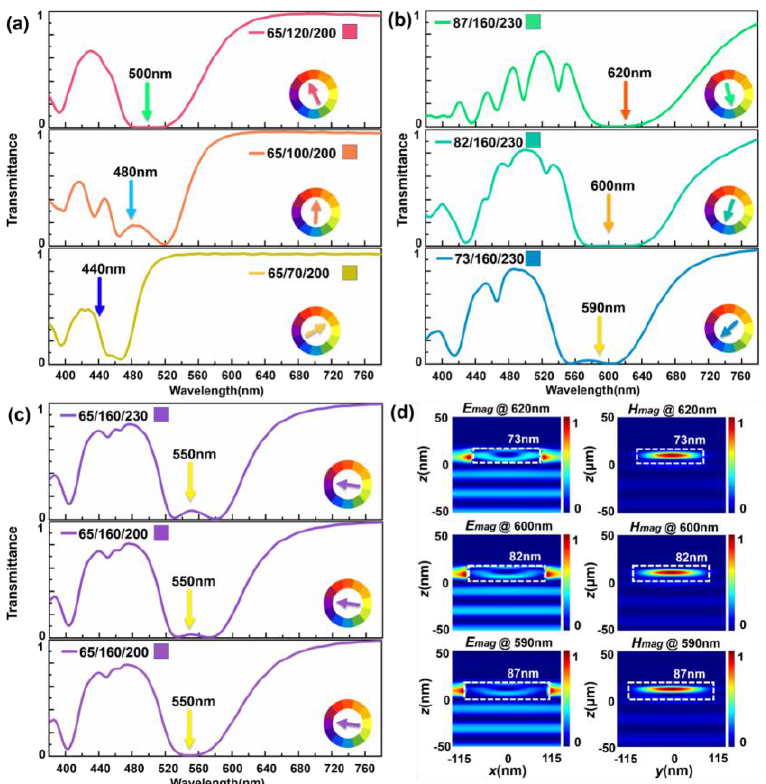
Figure 2. ( a – c ) The calculated reflection spectra of Si metasurface with different lattice sizes. ( d ) The electromagnetic field distributions of electric dipole mode and magnetic dipole mode of ( b ) at resonance wavelengths of 620 nm, ( b ) 600 nm and ( c ) 590 nm for a-Si nanopillars with radii of 87, 82 and 73 nm, respectively.